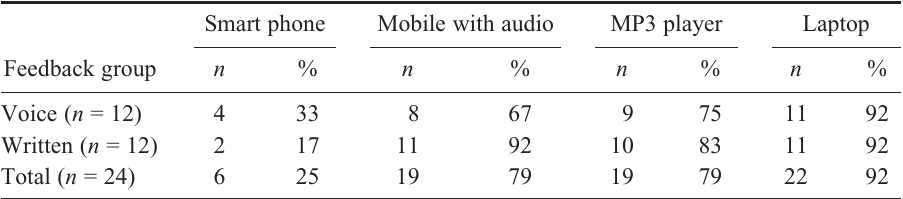
Table 5. Summary of mobile device ownership characteristics of student participants. Smart phone